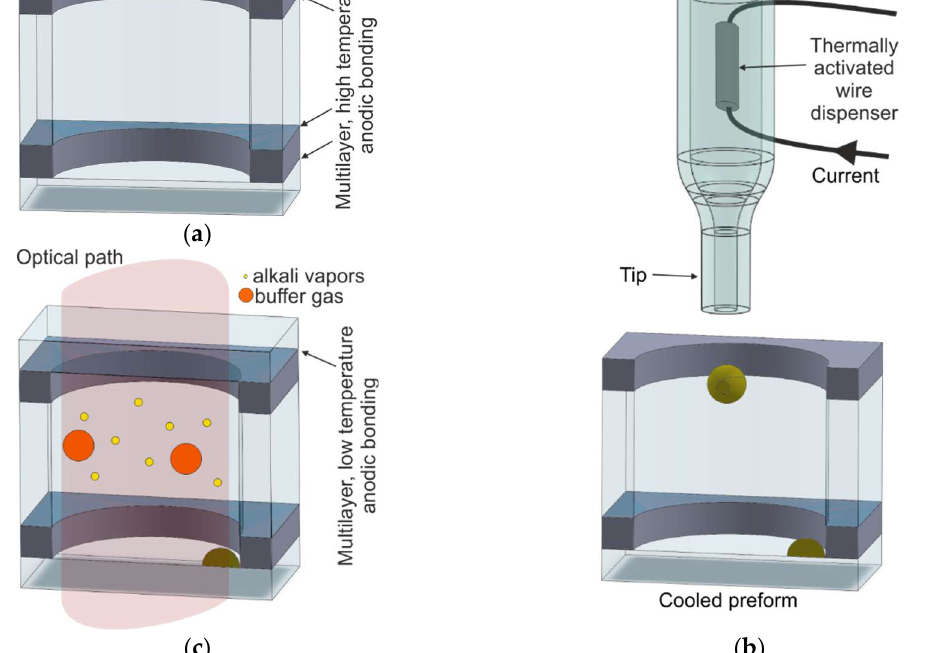
Figure 11. Multilayer cell fabrication: ( a ) four-layer glass–silicon preform, ( b ) drop of rubidium metal inserted into the preform, ( c ) cross section of the MEMS cell.